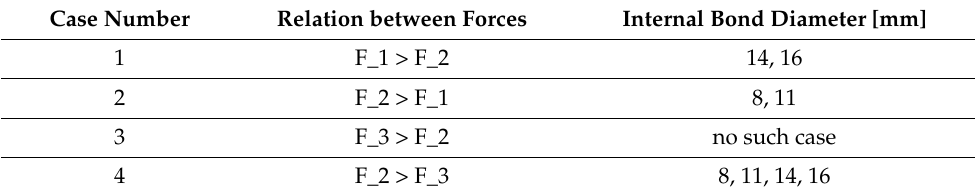
Table 3. Relation between forces for “E”